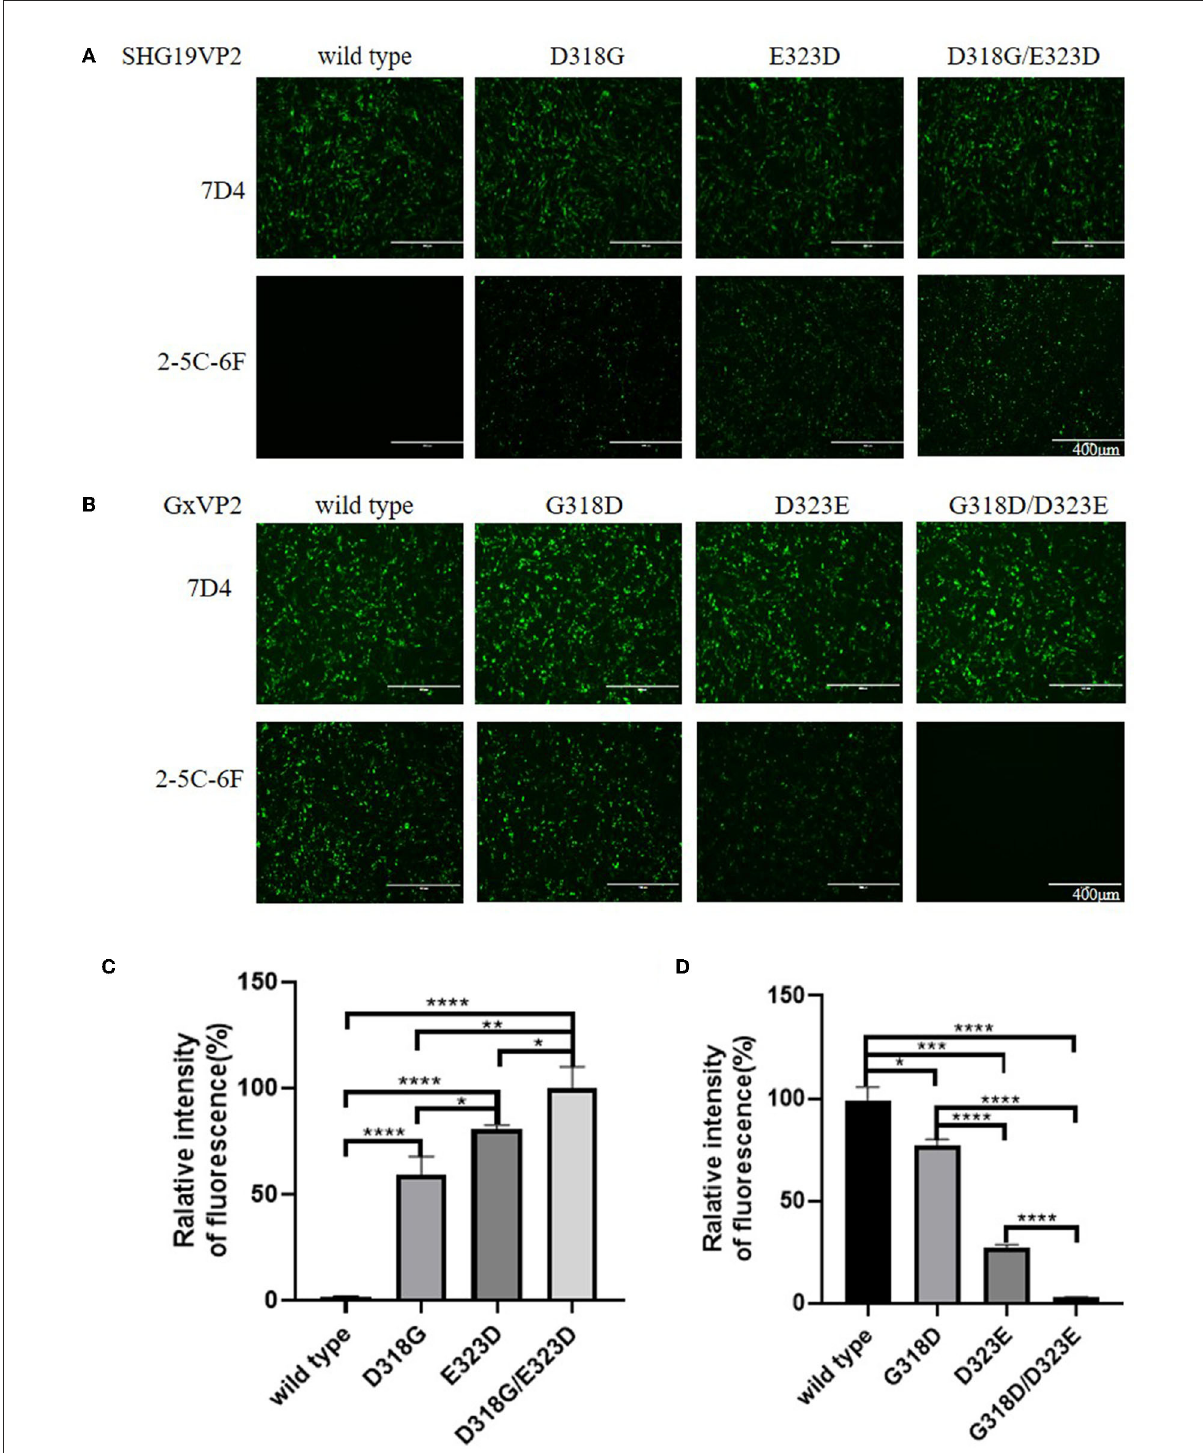
FIGURE4 Antigen recognition detection of the wild and mutated types of VP2 in DF1 cells directed by MAbs 7D4 and 2-5C-6F. (A) VP2 of the SHG19 strain (SHG19VP2) and its mutated types (SHG19VP2-D318G, SHG19VP2-E323D, and SHG19VP2-D318G/E323D). (B) VP2 of the Gx strain (GxVP2) and its mutated types (GxVP2-G318D, GxVP2-D323E, and GxVP2- G318D/ D323E). (C) Quantitative analysis of fluorescence of (A) . (D) Quantitative analysis of fluorescence of (B) . The mean fluorescence intensity and standard deviations (error bars) from three independent samples are shown. * represents P < 0.05, ** represents P < 0.01, *** represents P < 0.001, **** represents P <